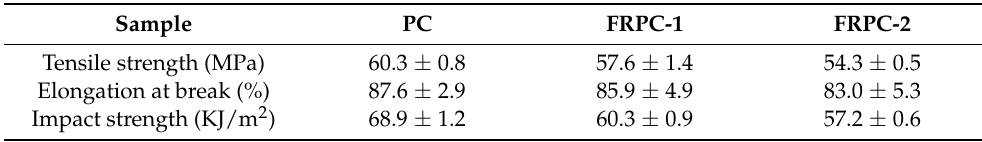
Table 5. Mechanical performances of PC and its FRPCs.